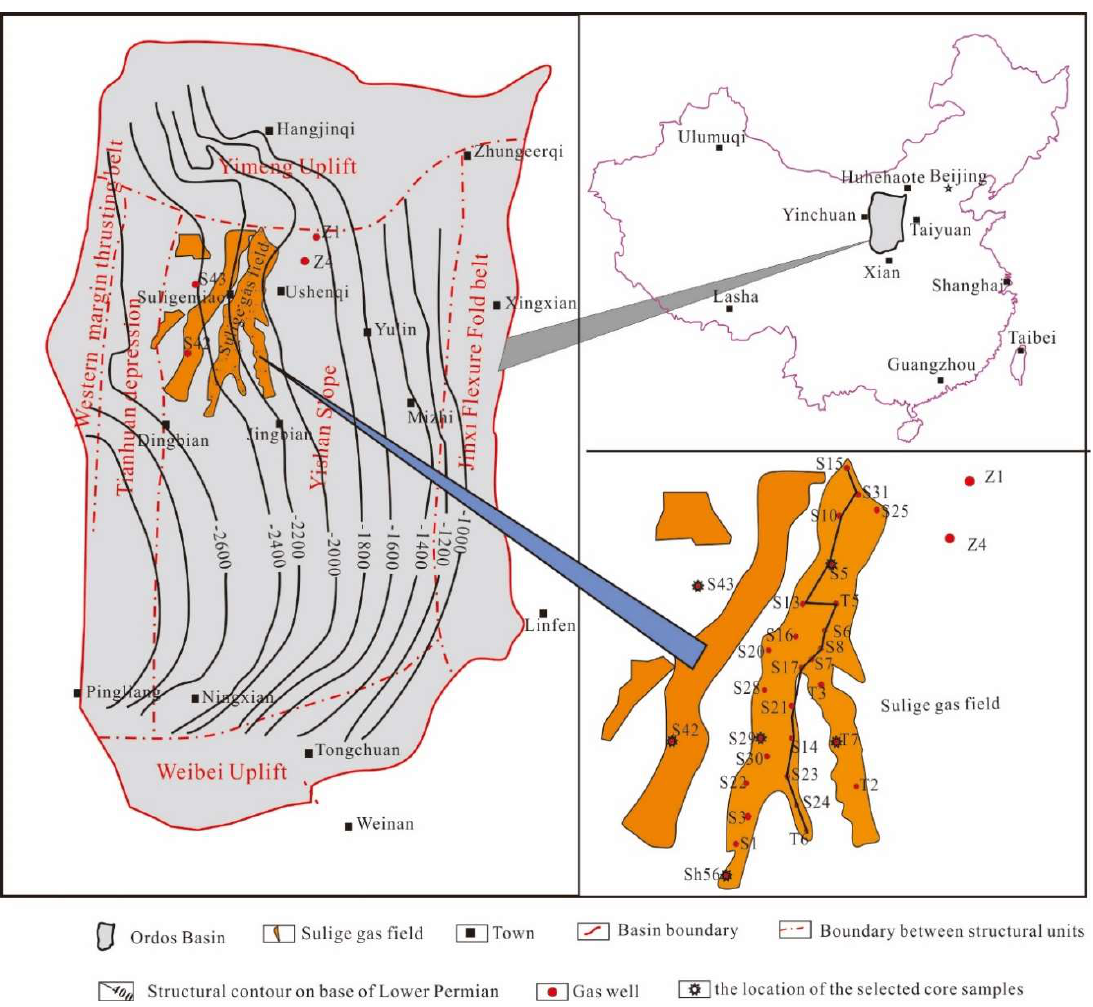
Figure 1. Location map of Sulige gas field in Ordos basin, and structural map at the base of the Lower Permian (modified from reference [25]).